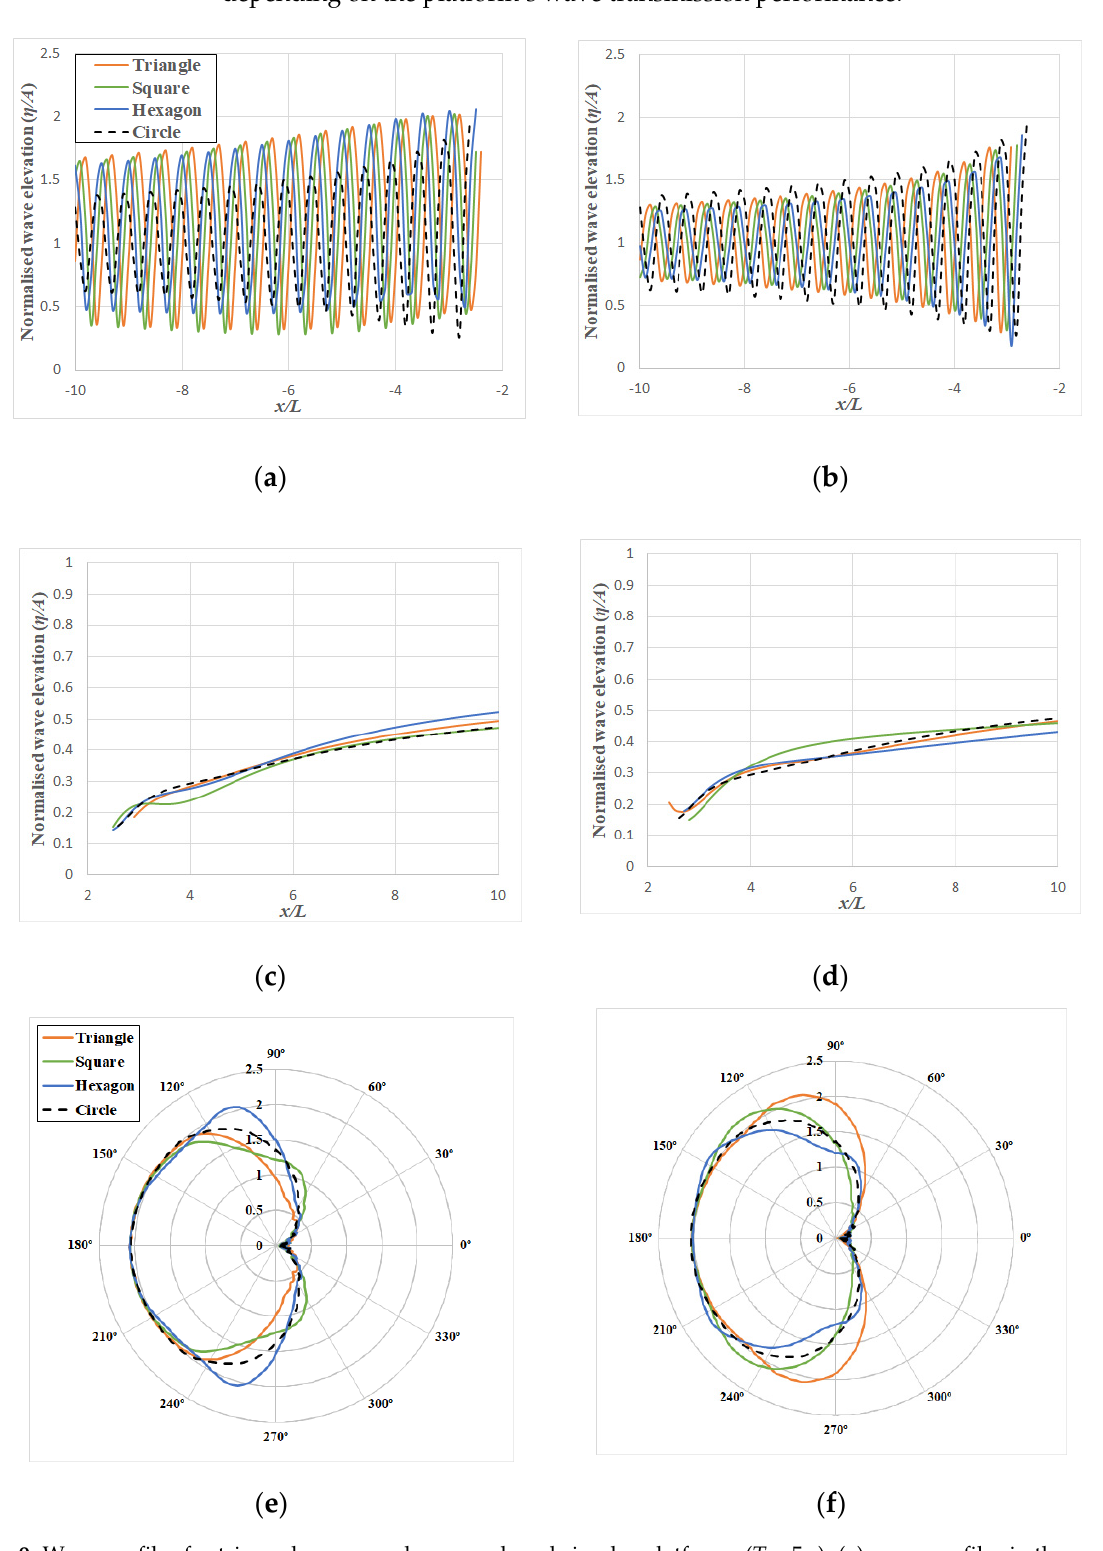
Figure 9. Wave profiles for triangular, square, hexagonal, and circular platforms ( T = 5 s): ( a ) wave profiles in the sea side for Case 1; ( b ) wave profiles in the sea side for Case 2; ( c ) wave profiles in the lee side for Case 1; ( d ) wave profiles in the lee side for Case 2; ( e ) wave runup for Case 1; and ( f ) wave runup for Case 2.